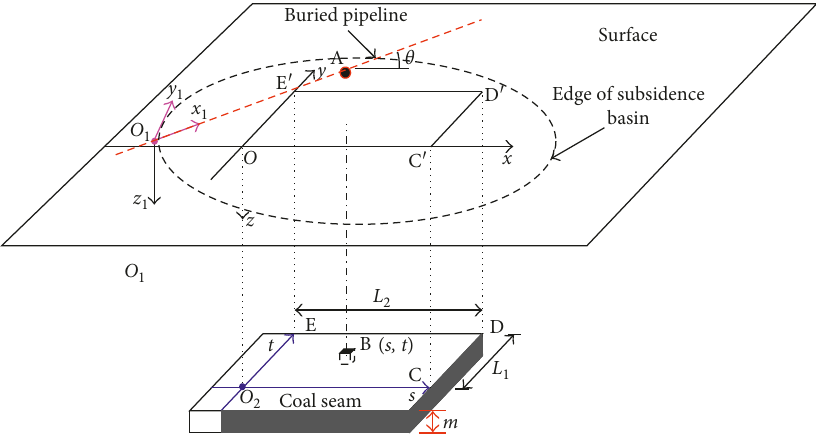
Figure 3: Surface, pipeline, and coal seam coordinate